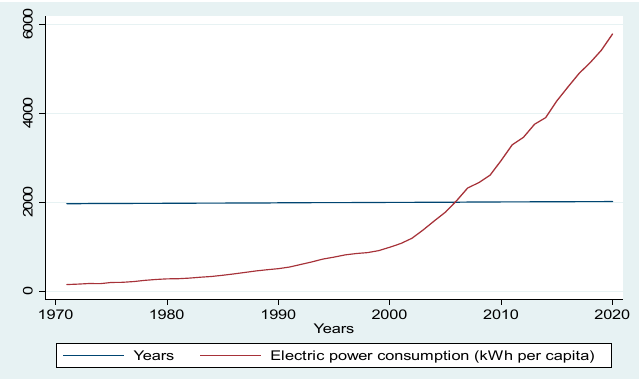
Figure 2. The electric power consumption trend for the economy of China for the period 1971–2020.